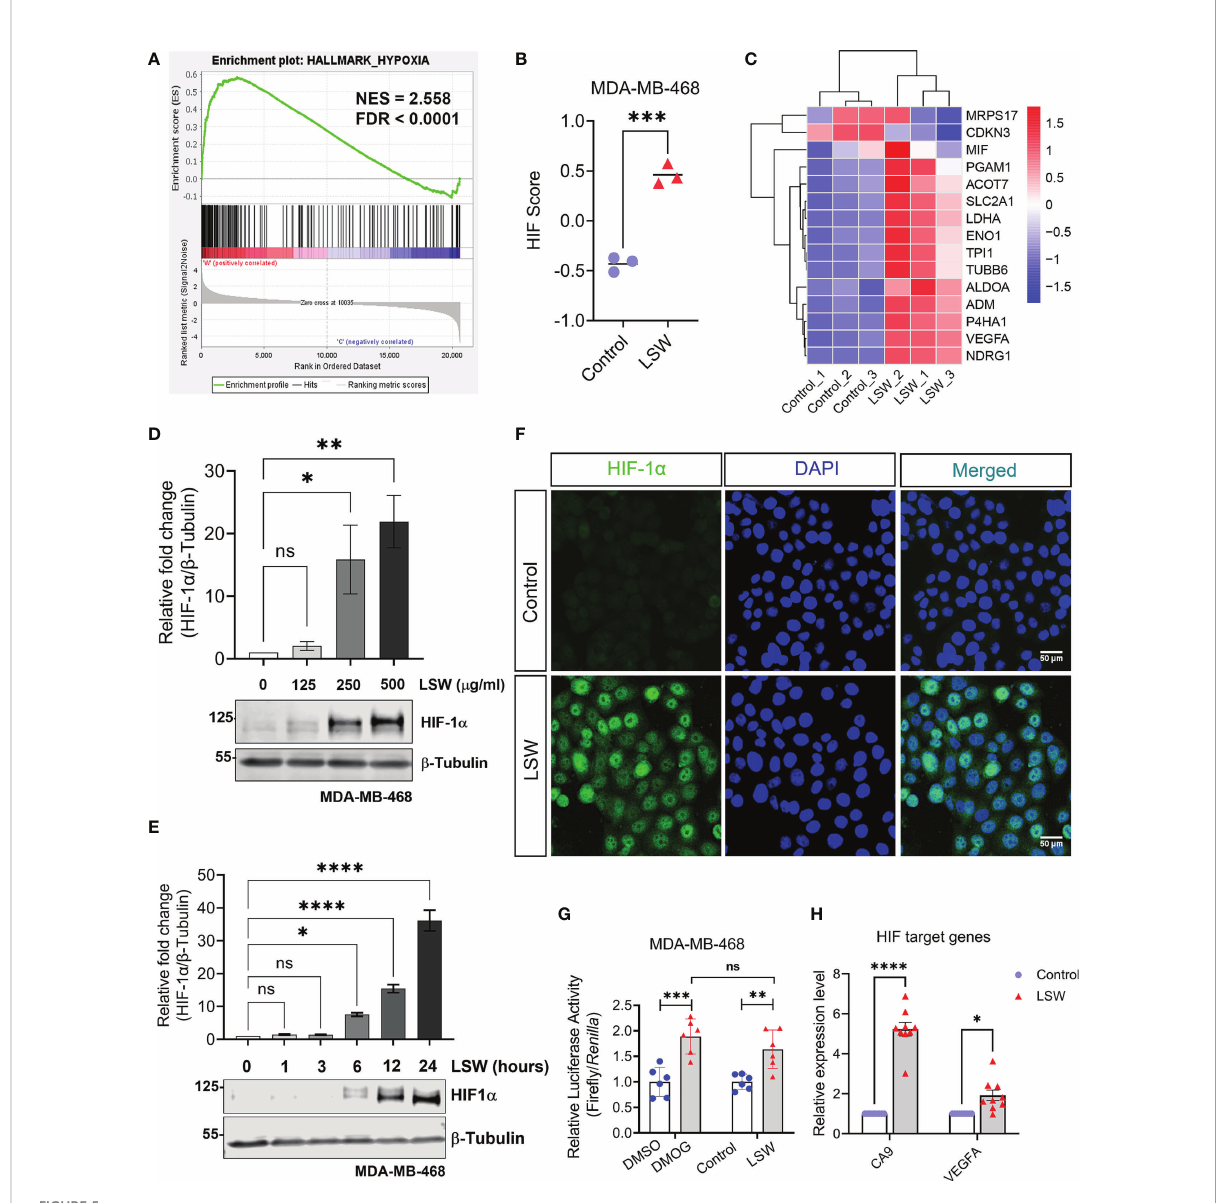
FIGURE 5 Effects of bioactive extracts from Limonium Sinense on hypoxia-inducible factor (HIF) activation. (A) Gene Set Enrichment Analysis (GSEA) plot showing enrichment of Hallmark_Hypoxia in MDA-MB-468 cells treated with Limonium Sinense water extracts (LSW, 500 m g/ml). Normalized enrichment score (NES) and false discovery rate (FDR) are indicated. (B) Graph showing HIF Gene Set Variation Analysis (GSVA) scores from control vs. LSW-treated MDA-MB-468 cells. Data are mean ± SEM; n = 3 samples per group. *** P < 0.001 by the Student ’ s t -test. (C) Heatmap showing the expressions of the 15 genes ( ACOT7 , ADM , ALDOA , CDKN3 , ENO1 , LDHA , MIF , MRPS17 , NDRG1 , P4HA1 , PGAM1 , SLC2A1 , TPI1 , TUBB6 , and VEGFA ) used to calculate the HIF score in control vs. LSW-treated MDA-MB-468 cells. Red indicates up-regulation and blue down- regulation. (D, E) Protein expressions of HIF-1 a in MDA-MB-468 cells with the indicated treatment. b -Tubulin was used as a loading control. Graphs showing relative protein levels of HIF-1 a . Data are mean ± SEM; n = 3 samples per group. ns, not signi fi cant; * P < 0.05; ** P < 0.01; **** P < 0.0001 by One-way ANOVA. (F) Immuno fl uorescence staining of HIF-1 a (green) in MDA-MB-468 cells with the indicated treatment. 4 ’ 6-Diamidino-2-Pheylindole (DAPI) (blue) was used to stain nuclei. Scale bars: 50 m m. (G) Graph showing the Hypoxia Response Element (HRE) reporter assay in MDA-MB-468 cells with the indicated treatment. Values represent the relative fold change of Fire fl y luciferase to Renilla luciferase, normalized against control (1.0). Data are mean ± SEM; n = 6 samples per group. ns, not signi fi cant; ** P < 0.01; *** P < 0.001 by Dunnett ’ s multiple comparisons test. (H) Graph showing fold change in mRNA levels of HIF-1 a target genes ( CA9 and VEGFA ) in MDA-MB-468 cells with the indicated treatment. b -actin-normalized mRNA levels in control cells were used to set the baseline value at unity. Data are mean ± SEM; n = 9 samples per group. * P < 0.05; **** P < 0.0001 by the Student ’ s t